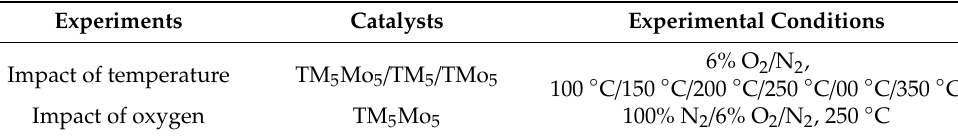
Figure 11. The experimental system. Table 2. The experimental